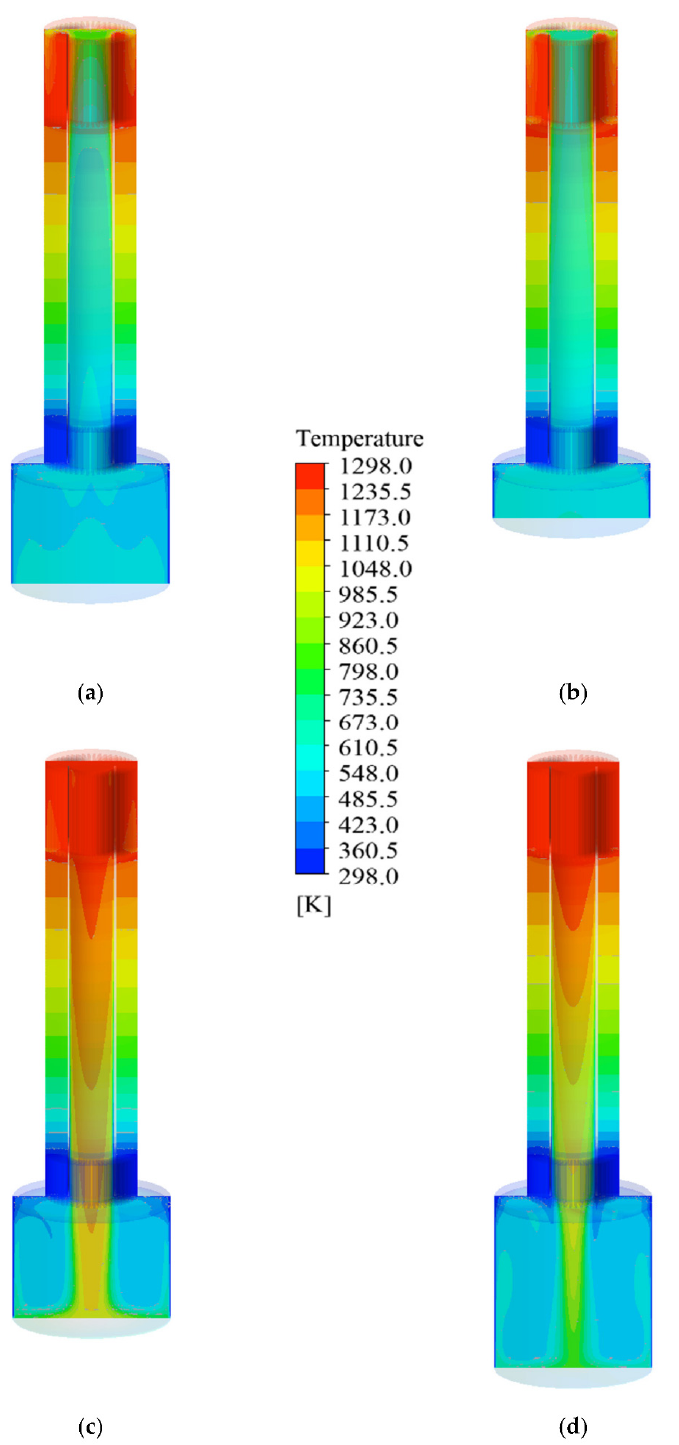
Figure 6. Temperature contours at four typical instances: ( a ) 0 degrees; ( b ) 90 degrees; ( c ) 180 degrees; ( d ) 270 degrees.